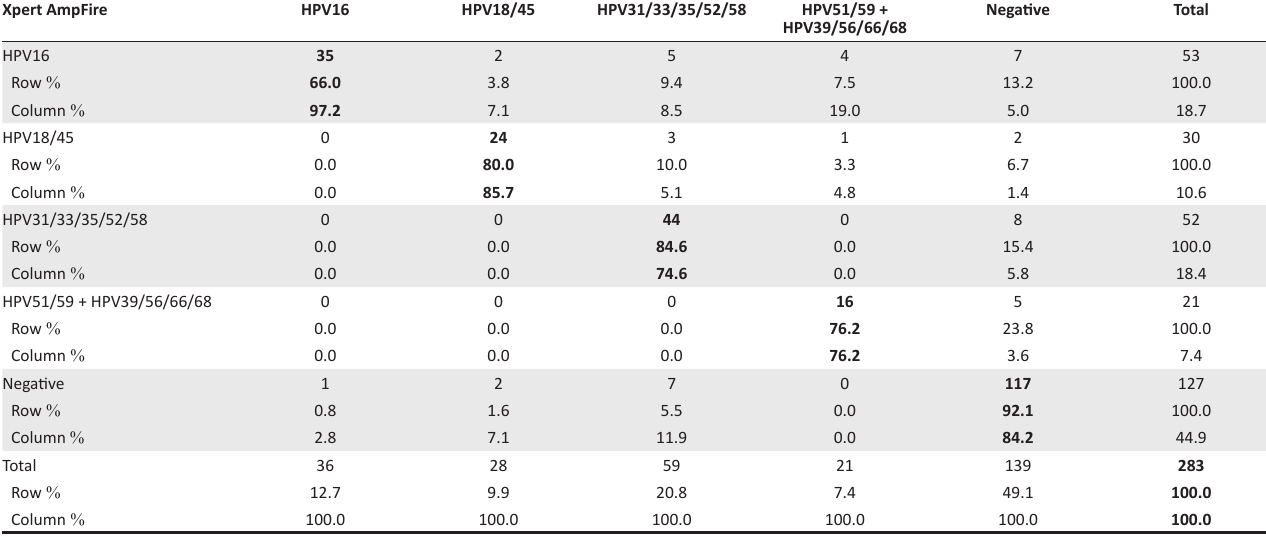
TABLE 2: Pairwise AmpFire and Xpert results, categorised hierarchically according to HPV risk groups, Rwanda, June 2018 - June 2019. Xpert